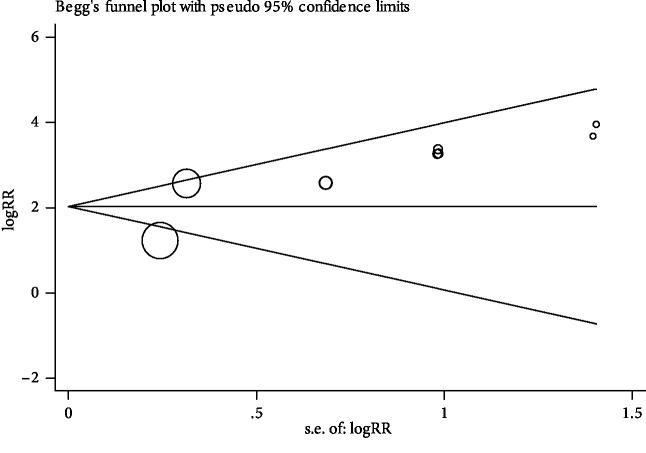
Begg's funnel plot of publication bias (P = 0.25).